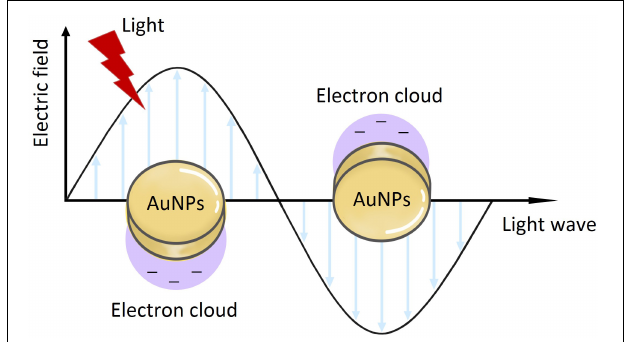
FIGURE 11 | The application of AuNPs on the